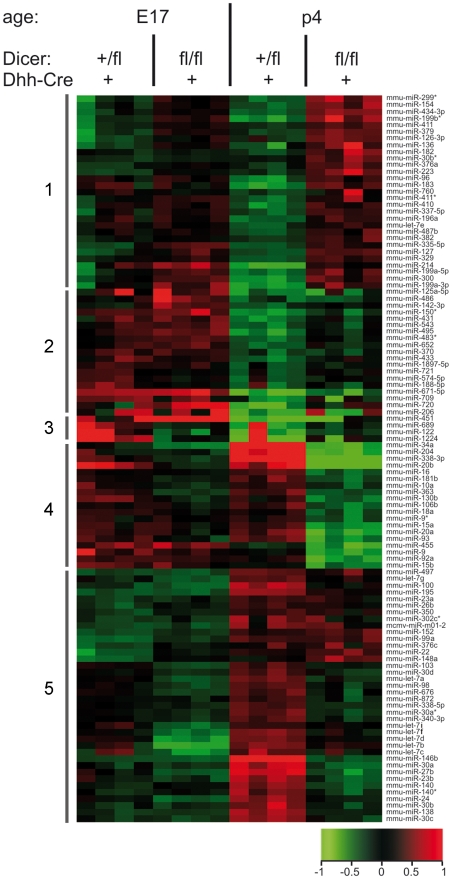
Heat map of developmentally and/or Dicer dependently regulated miRNAs in sciatic nerves.Expression of miRNAs in sciatic nerves of E17 and p4 Dicerfl/fl Dhh-Cre+ and control Dicerwt/fl Dhh-Cre+ littermates was analyzed by miRNA microarray. Four biological replicates for each group were analyzed on separate arrays. Of the 216 miRNAs expressed, 109 miRNAs (listed on the right side of the heat map) were differentially expressed, either in an age-dependent manner or in a manner dependent on the expression of Dicer in Schwann cells (p≤0.05, log2 ratio≥0.5). Differential expression in log2 ratio is color coded as indicated in the legend below the heat map (red = upregulation, green = downregulation). Based on hierarchical clustering, five groups, each containing miRNAs of similar expression pattern are indicated by gray bars on the left side. Group 1 contains miRNAs which are upregulated in Dicerfl/fl Dhh-Cre+ compared to Dicerwt/fl Dhh-Cre+ nerves at E17 and at p4. Group 2 contains miRNAs that are downregulated in both genotypes at p4 compared to E17. Group 3 includes miRNAs that are downregulated in Dicerwt/fl Dhh-Cre+ nerves at p4 when compared to E17 and downregualted in Dicerfl/fl Dhh-Cre+ compared to Dicerwt/fl Dhh-Cre+ nerves at E17. Group 4 contains miRNAs which are downregulated in Dicerfl/fl Dhh-Cre+ compared to Dicerwt/fl Dhh-Cre+ nerves at p4 and are abundantly expressed also in Dicerwt/fl Dhh-Cre+ nerves at E17. Group 5 includes miRNAs that are upregulated in Dicerwt/fl Dhh-Cre+ nerves at p4 compared to both, Dicerfl/fl Dhh-Cre+ and Dicerwt/fl Dhh-Cre+ nerves at E17.